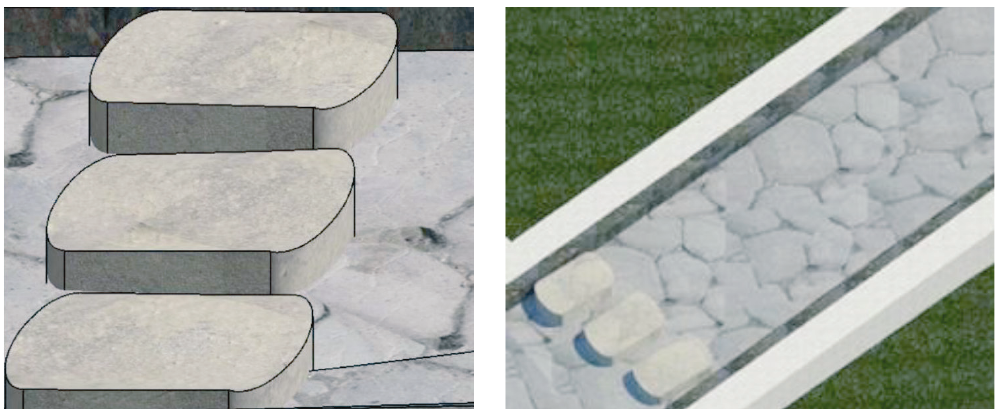
Figure 6. Section of Via del Vesuvio (Seiler, Beste, Piraino & Esposito, 2005) and its relative 3D